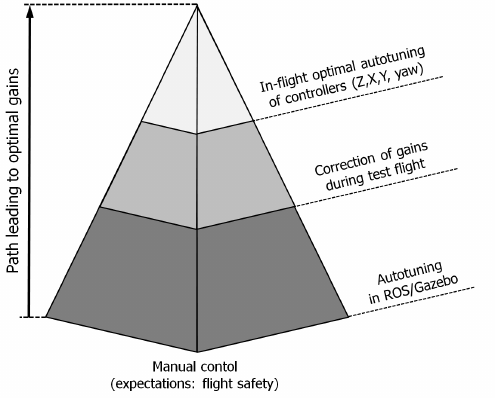
Figure 5. Following steps to obtain optimal gains of